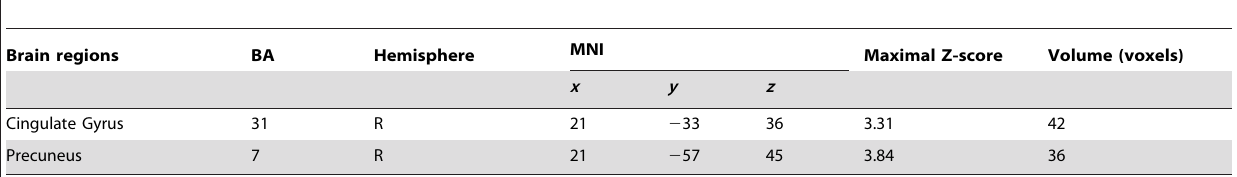
Table 4. Brain areas with significant different ReHo values in the MCI patients after acupuncture at P , 0.01 (Alphasim corrected, p , 0.01, 30